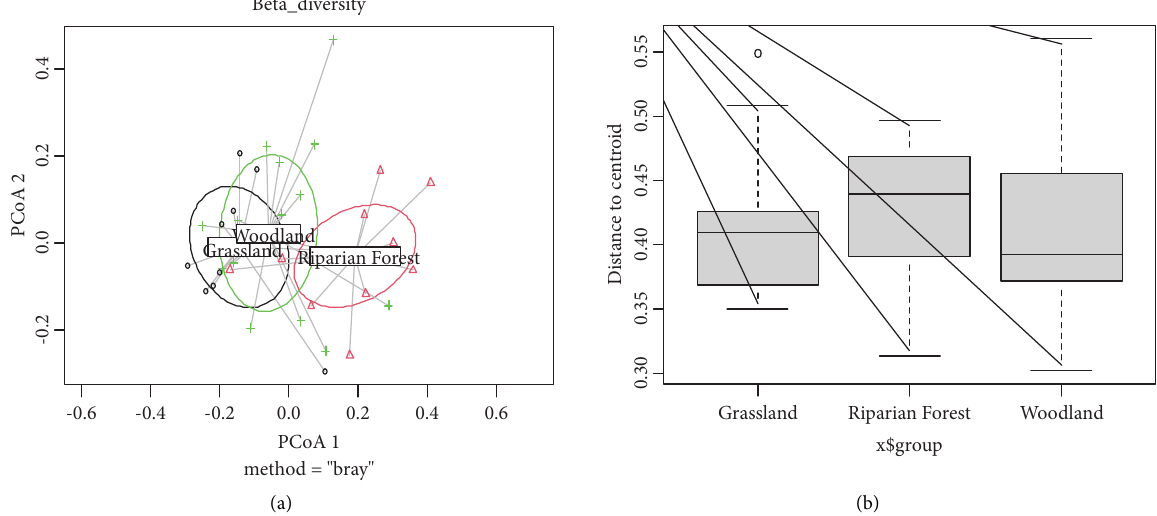
Figure 3: (a) A principal coordinate analysis (PCoA) plot showing that the frst two axes explained 60% of the variation among the habitats. (b) Boxplot of the variations in species composition among the three habitat types in